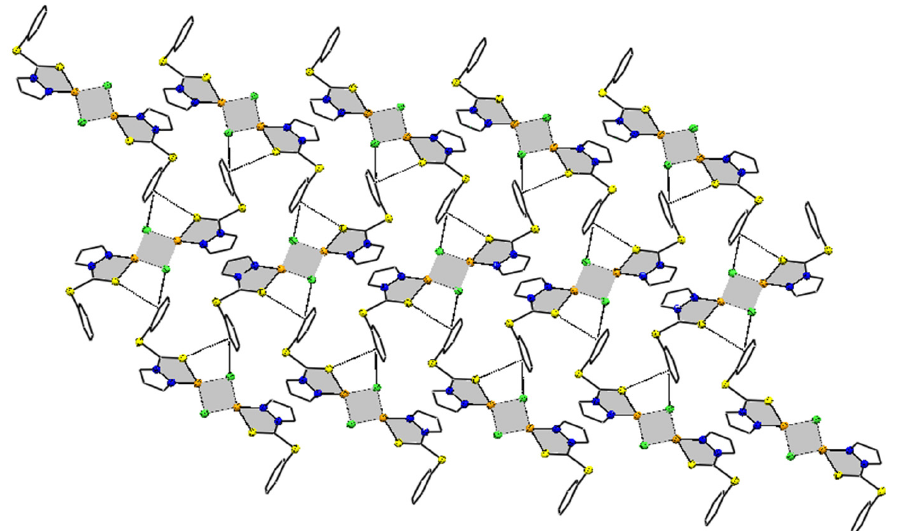
Figure 2. Supramolecular fragment of compound 1 stabilized by C(6)(p) · · · Cl(1)(p) and S(1) · · · C(6)(p) interaction, with separation distance of 3.688 and 3.354 Å, respectively. The five- and four-membered rings containing Cu are shown shaded, to make the interactions reader friendly. Hanging contacts and all hydrogen atoms are deleted for simplicity.